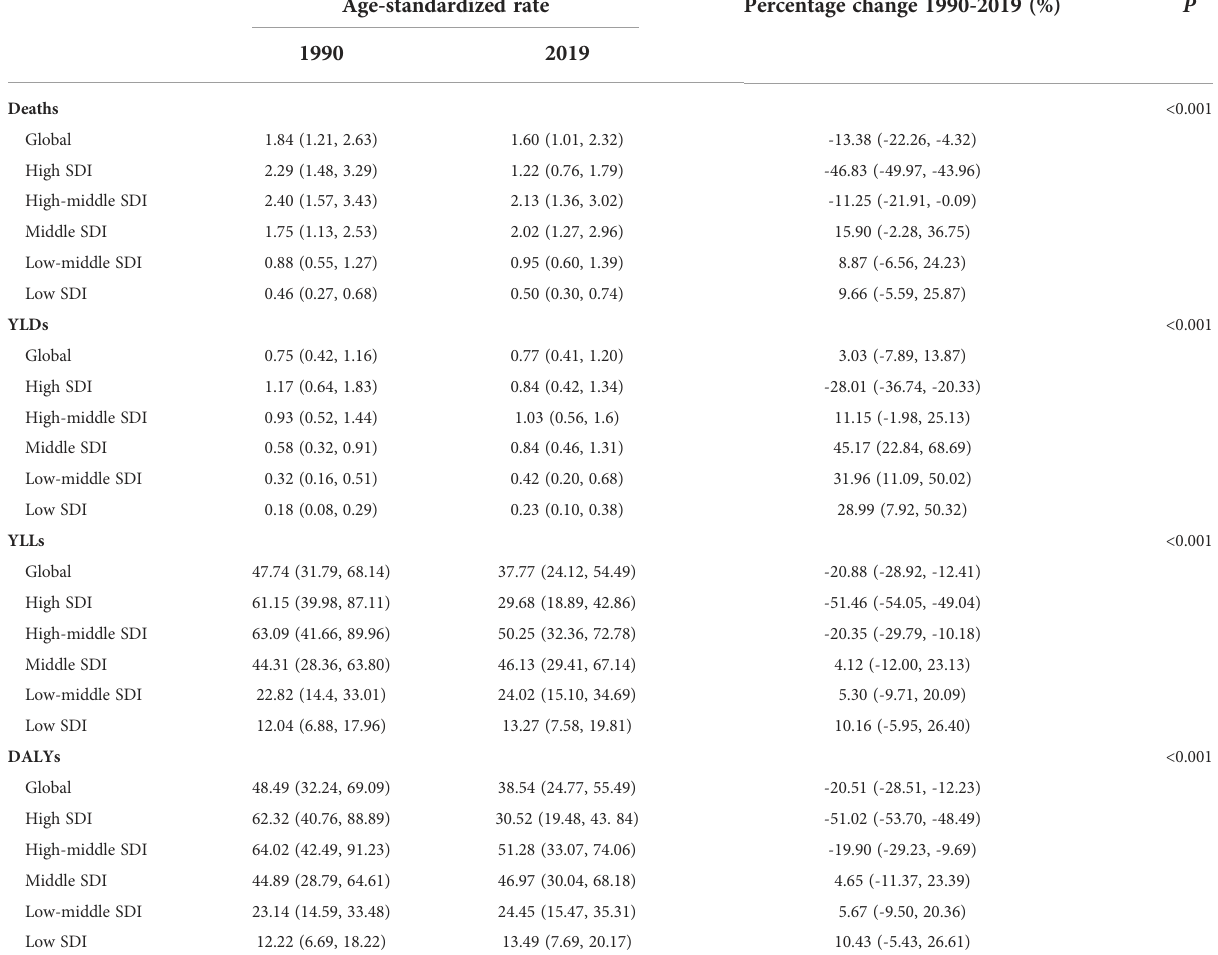
TABLE 3 Cancer burden attributable to secondhand smoke in 5 SDI groups for both sexes combined in 1990 and 2019 and percentage change from 1990 to